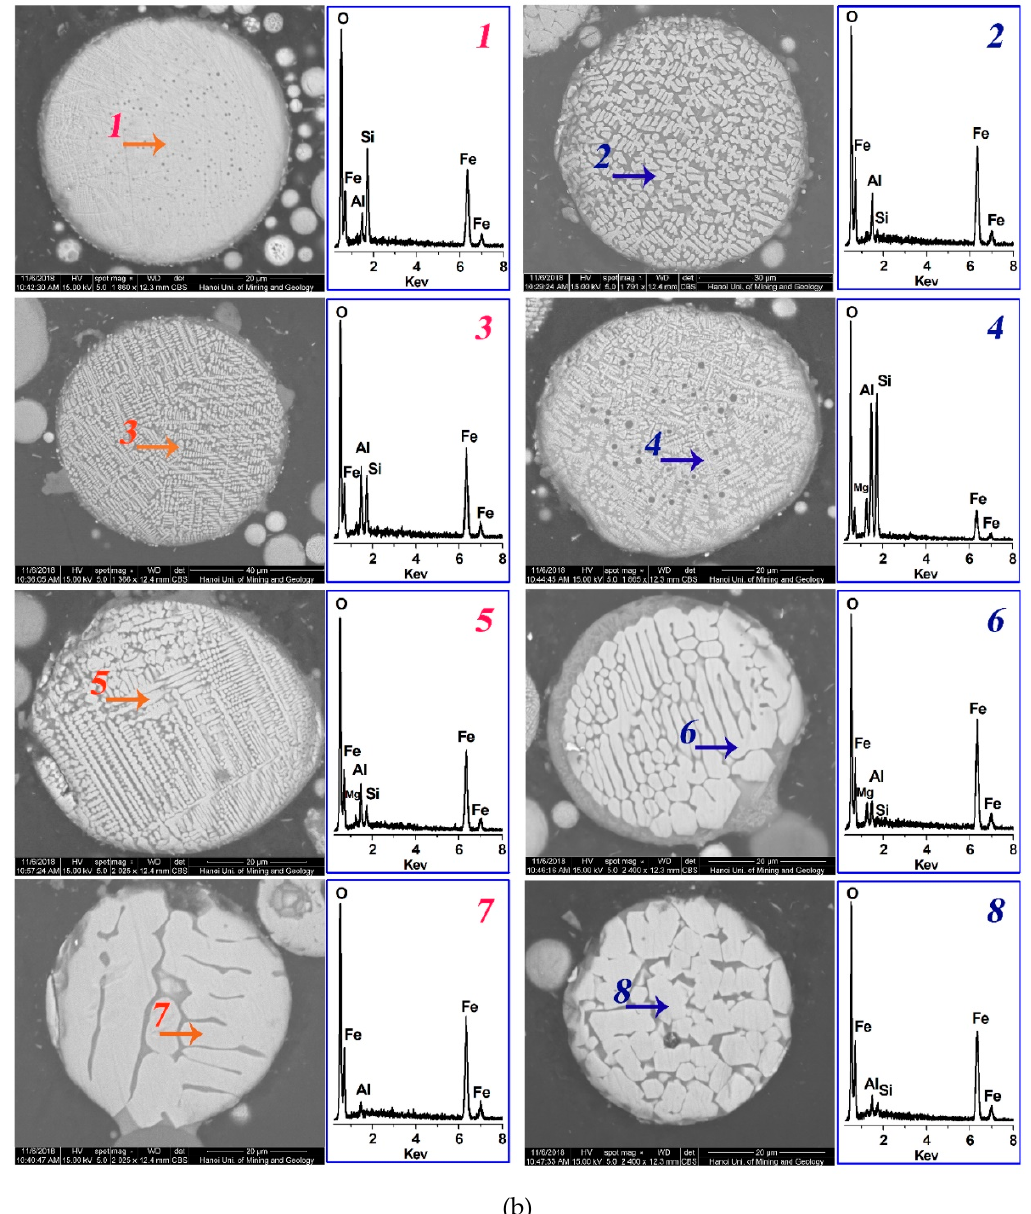
Figure 5 (a) SEM-EDS results of Uong Bi (UB) magnetic fly ash. SEM-EDS results of Pha Lai (PL) Figure 5. ( a ) SEM-EDS results of Uong Bi (UB) magnetic fly ash. ( b ) SEM-EDS results of Pha Lai (PL) magnetic fly ash. magnetic fly